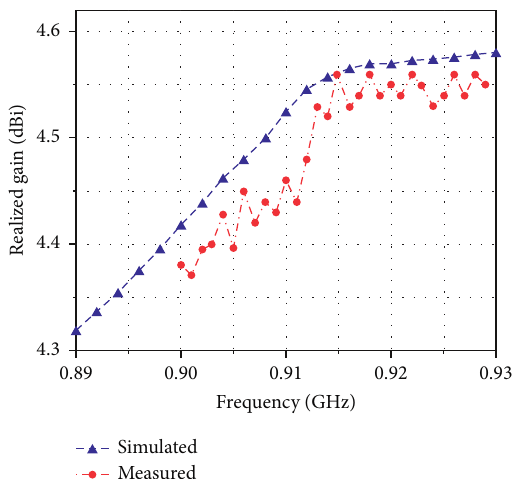
11 | for the proposed antenna.